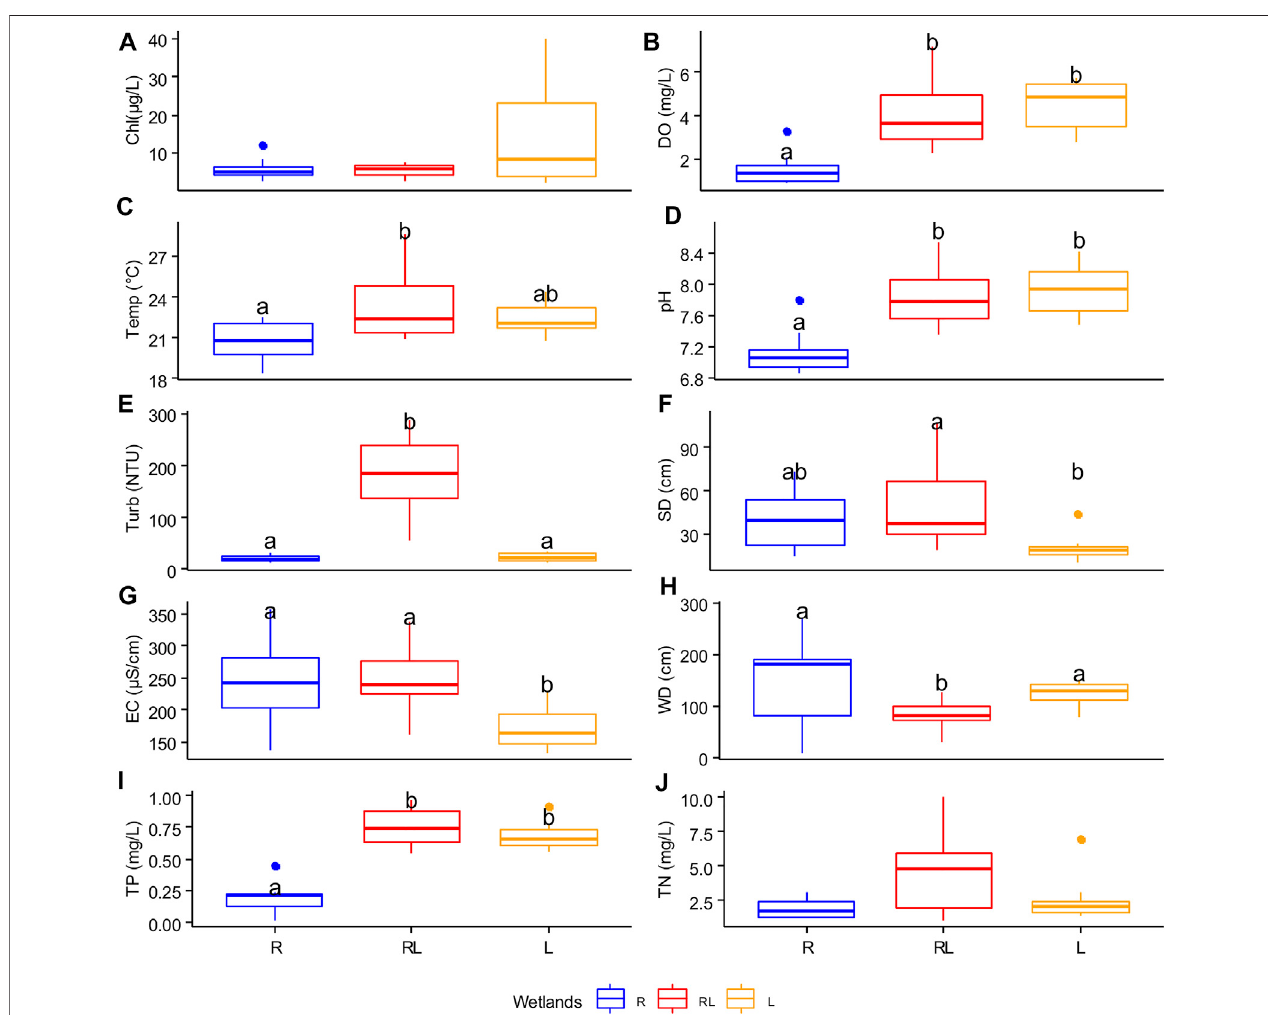
FIGURE 4 | Boxplot plots with the median (solid line) for each measured environmental variable (A – J) in R = riverine papyrus swamps, RL = river mouth wetlands, andL=lacustrinewetlands(datawerecombinedfromdryandwetseasons).pH, SD sedimentdepth ,WD waterdepth ,Chl chlorophyll-a,ECspeci fi cconductance ,Turb turbidity , DO dissolve oxygen concentration , and Temp temperature. Boxes that do not have a letter in common are signi fi cantly different from each other.